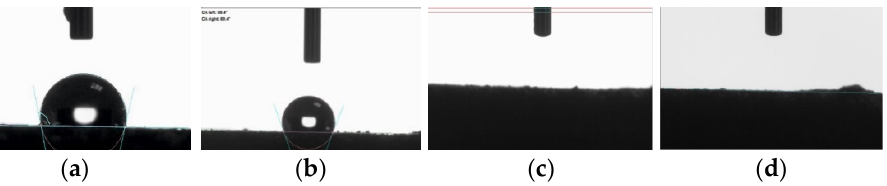
Figure 5. Contact angle of formation water drop at Bashkirian stage core: ( a ) Initial (the core is saturated with brine); ( b ) After 1 h of aging in Composition-1 solution; ( c ) After 4 h of aging in Composition-1 solution; ( d ) After 24 h of aging in Composition-1 solution.